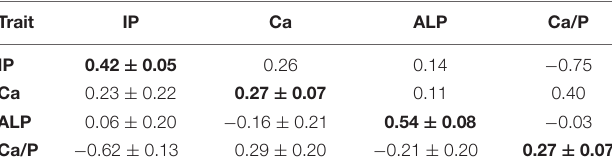
TABLE 2 | Estimates of genetic (below the diagonal) and phenotypic (above the diagonal) correlation coefficients and the genomic heritability (diagonal, bold) for concentrations of IP, Ca, ALP, and Ca/P